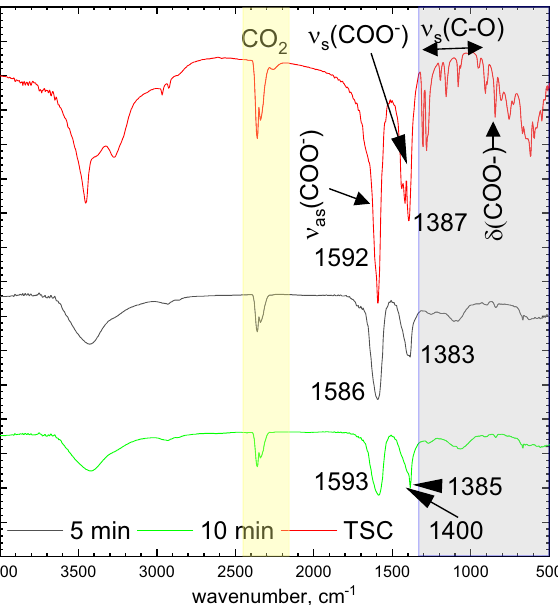
Figure 9. FT-IR spectra registered for the dried colloid obtained when [Pt(IV)] = 1 × 10 −4 [TSC] = 2 × 10 −3 M, T max = 225 °C and TSC for comparison.